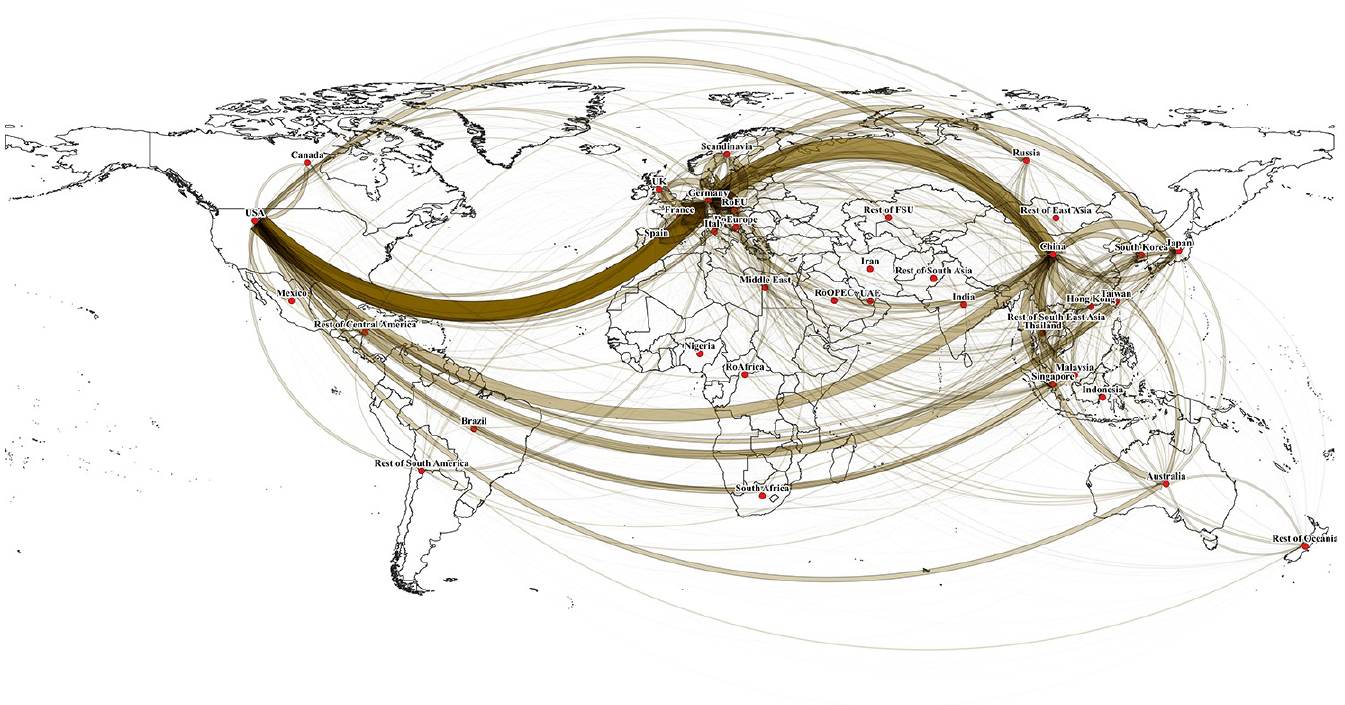
Fig 3. Wage and salary income losses as a consequence of trade volume reductions in international supply chains due to the global COVID-19 effects. Lines connect ultimate origins and destinations of supply chains, both direct and multi-node. Line thickness represents trade volume lost.